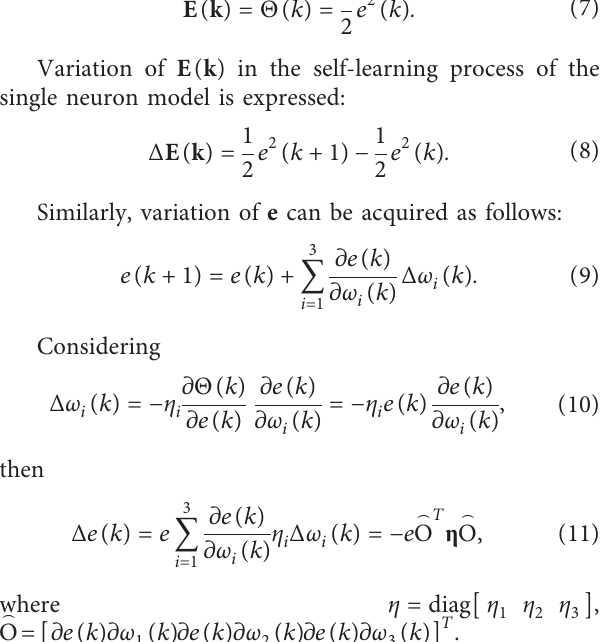
Figure 6: Prototype of the rehabilitation ankle robot driven by